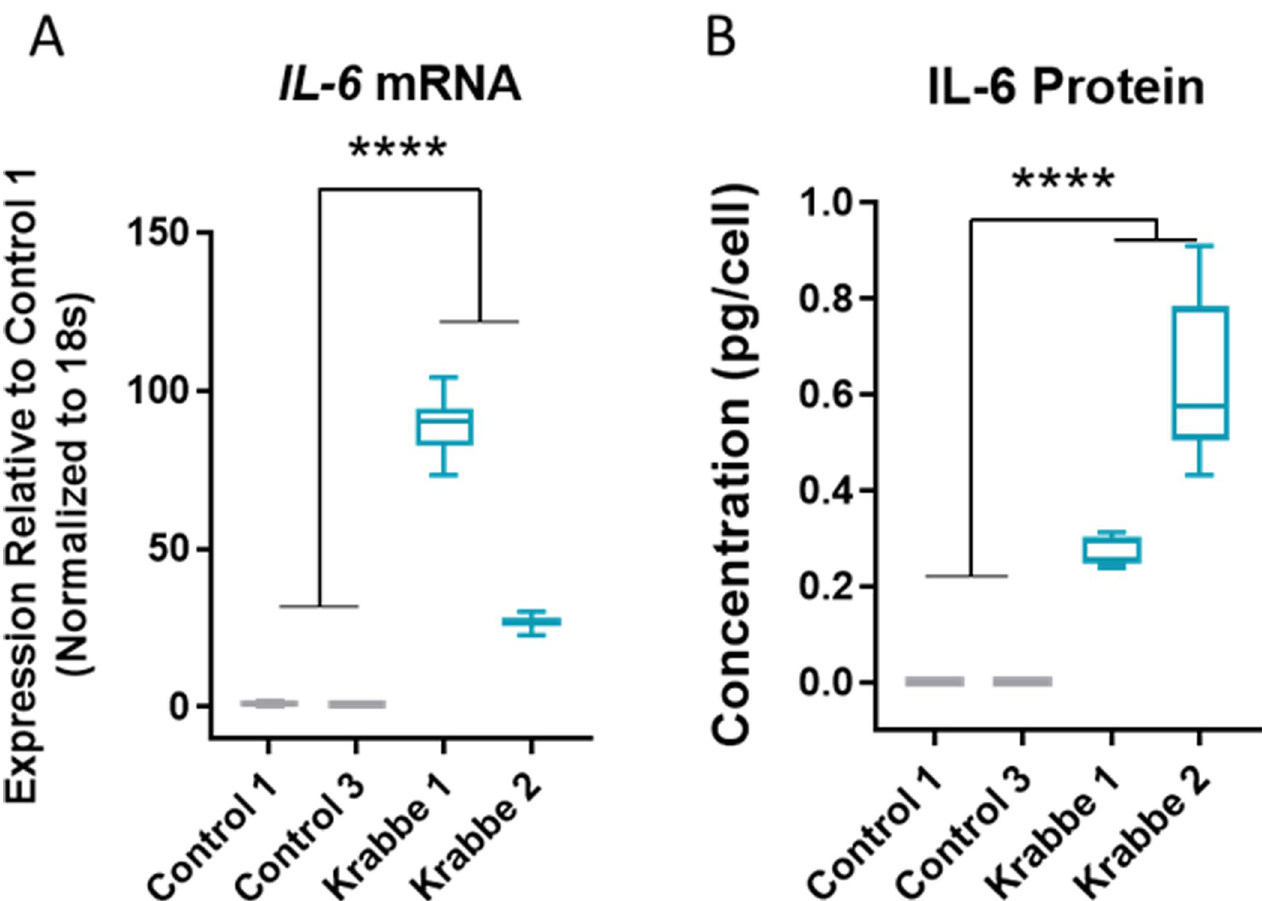
Fig 2. Upregulation of IL-6 in Krabbe astrocytes. Significantly greater IL-6 (A) mRNA and (B) protein expression was observed in astrocytes derived from the donors with Krabbe disease. ���� p < 0.0001. Data for individual donor subjects is shown as a box and whisker plot with median represented and errors bars indicating min/max values. Statistical analysis was conducted using t-tests on pooled data comparing control vs. Krabbe cells.